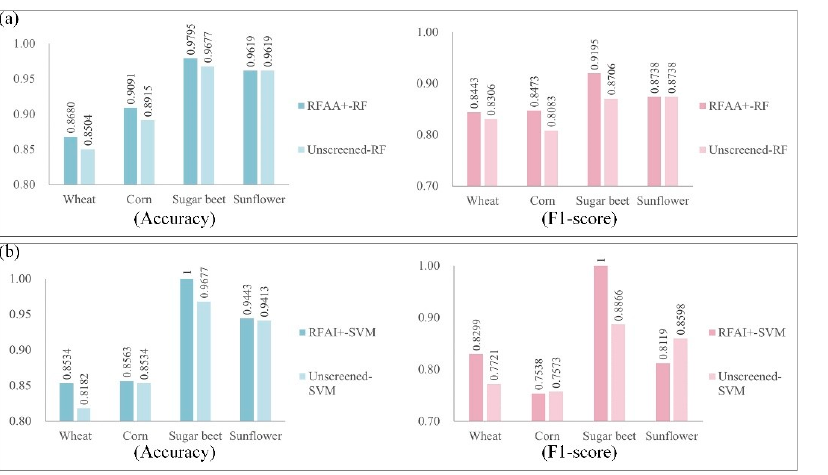
Figure 7. Evaluation indicators of single crop under different FS-ML models: ( a – g ) include the eval- uation indicators (e.g., accuracy and F1-score) optimal coupling results of the specific classifier and